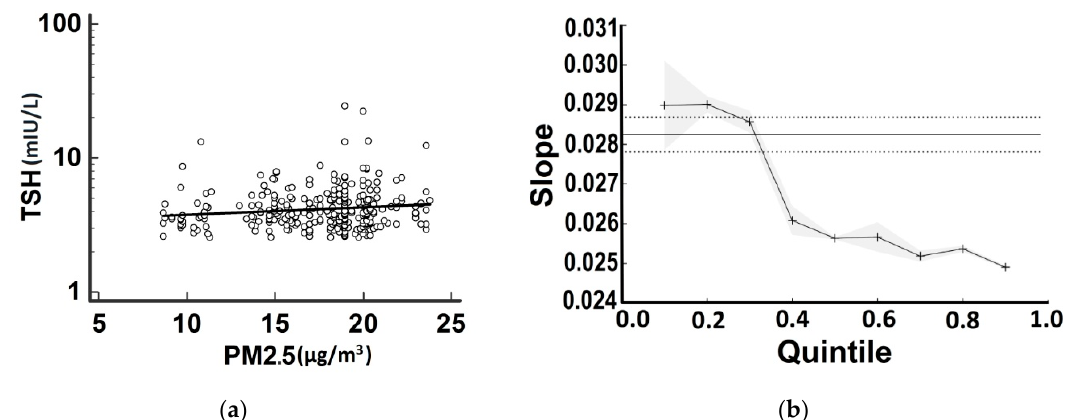
Figure 3. Scatter diagram with OLS-R for PM2.5 vs. logTSH ( a ) Graph of slopes for PM2.5 over logTSH (mIU / L) produced by Q-R ( b ) Note that the 0.5 quantile corresponds to the median and that the associations between each predictor are estimated to be stronger (over the levels estimated by OLS-R) at lower quantiles of response (i.e., TSH) and weaker (lower than the levels estimated by OLS-R) at higher quintiles of response. The straight line with dashed line borders indicates the OLS-R estimate with 95% confidence intervals, whereas the splined line with grey borders indicates the Q-R estimates with 95% confidence intervals.